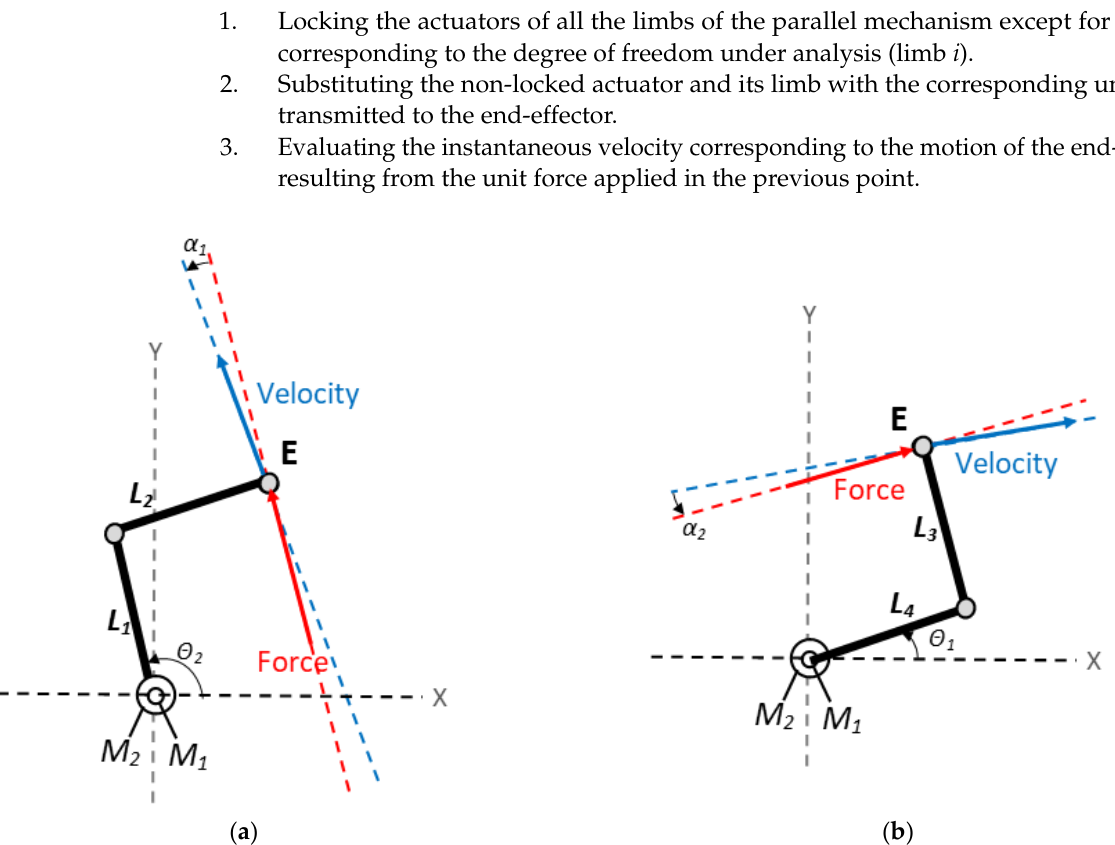
Figure 6. Kinematic diagram of the 5-bar linkage of Nurse with main twist and wrench directions: ( a ) pressure angle of the first limb in an example configuration; ( b ) pressure angle of the second limb in an example configuration.